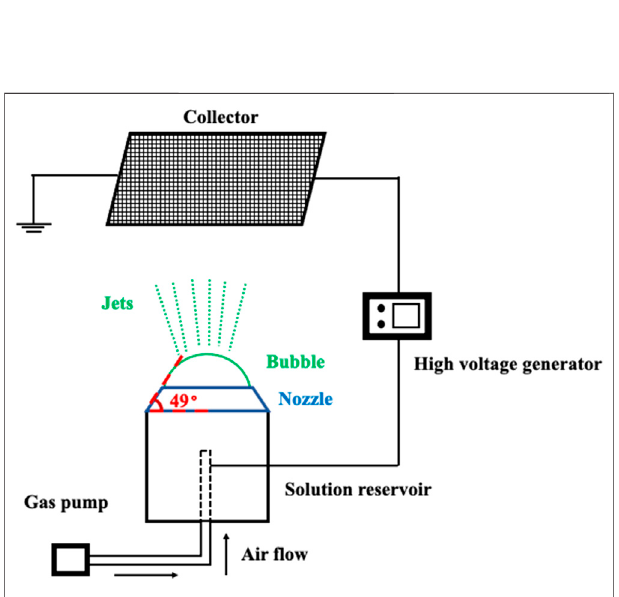
FIGURE 2 | Schematic illustration of the bubble eletrospinning.